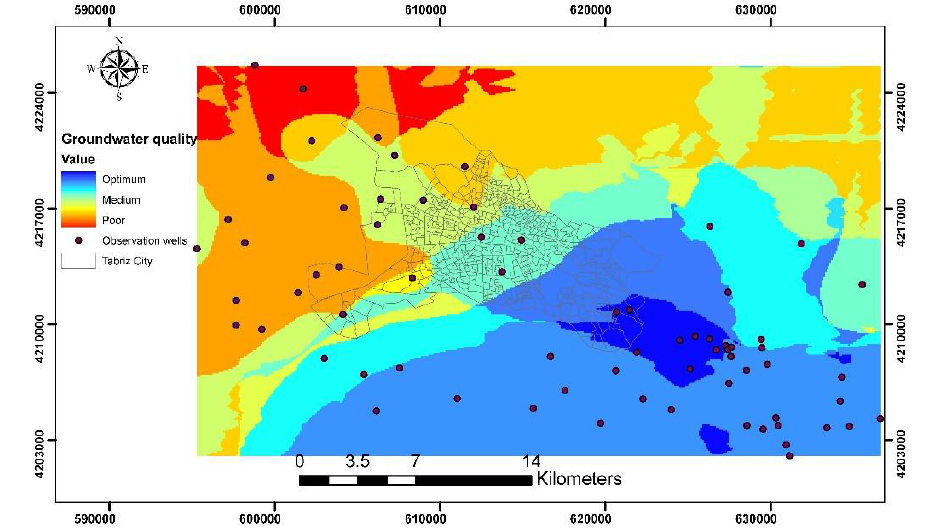
Fig 5. Water quality map using AHP method (optimum in blue and poor in red)